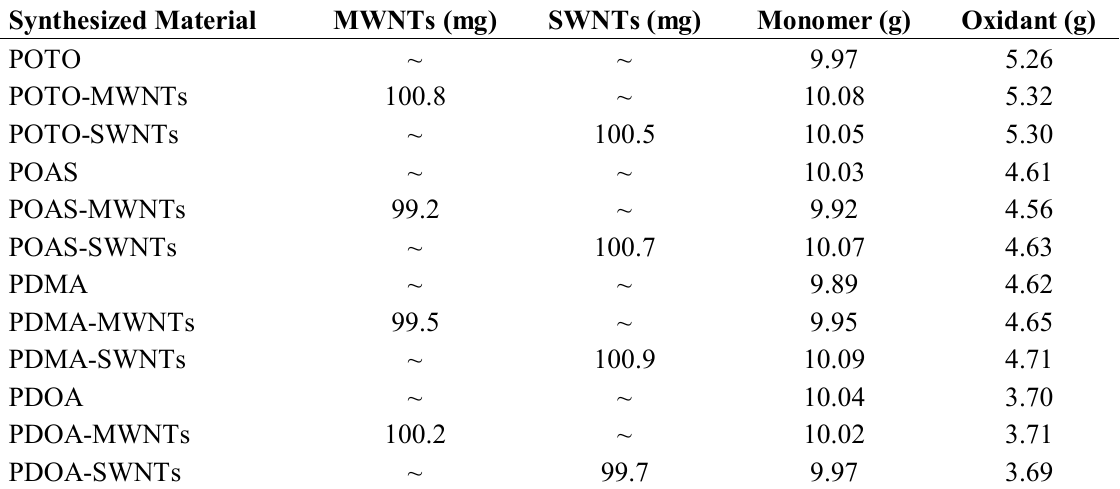
Table 1. Amounts of reagents used for the synthesis of the materials carried out in 200 mL of 1 M HCl aqueous